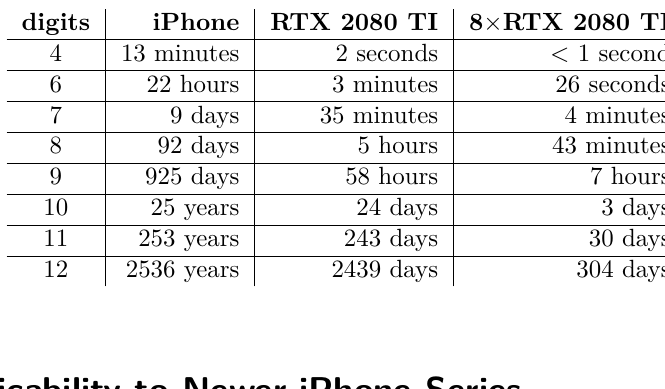
Table 1: Worst-case passcode search